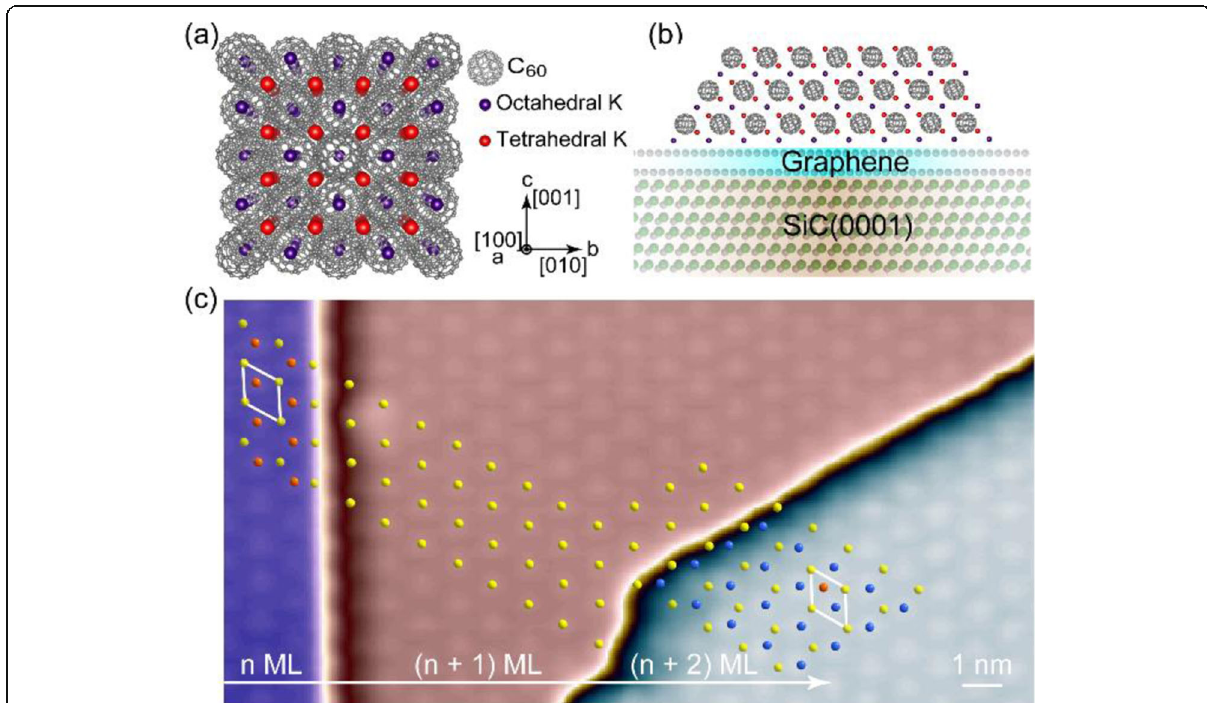
Fig. 2 ( a ) Crystal structure of fcc K 3 C 60 . ( b ) Schematic side view of K 3 C 60 (111) films on graphitized SiC substrate. ( c ) STM topography ( V = 3.0 V, I = 10 pA) showing three consecutive K 3 C 60 layers. Taken from ref.